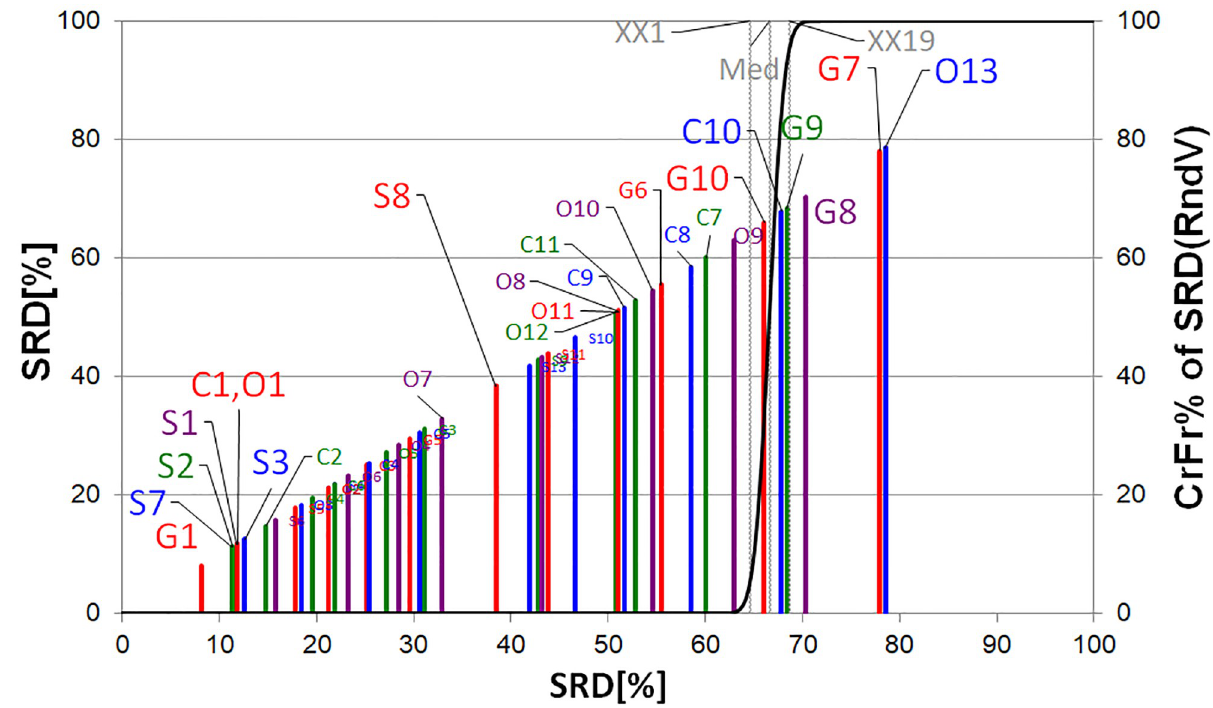
Fig 10. Representation of the objectives by SRD. The SRD range between 0 and 8 is empty, i.e. , the total number of authorships (G1) is close to the ideal reference. The range between the lines XX1 (5%) and XX19 (95%) shows the random ranking. Objectives to the right-hand side of the line of XX19 are ranked in reverse order (G7-G9, O13). The solid black line on the second vertical axis indicates the cumulative random frequencies of SRD vectors (CrFr% of SRD(RndV)).